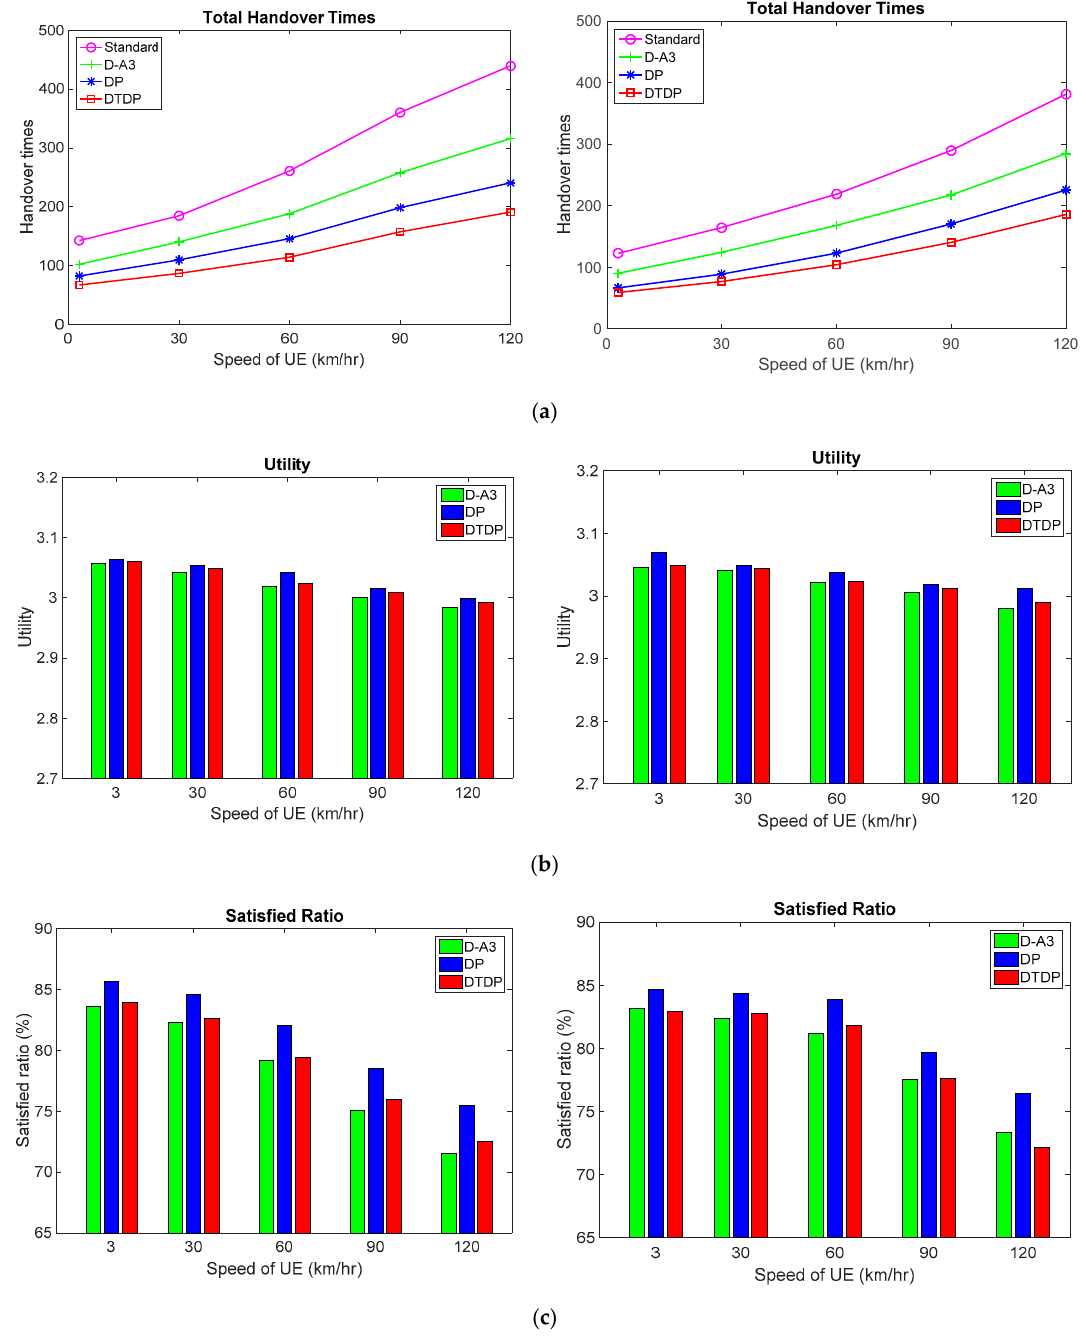
Figure 5. Total number of handovers, utility, and satisfied ratio versus the moving speed of each D2D user under different mobility models. The charts on the left and the charts on the right correspond to the FD model and RPGM model, respectively. ( a ) Total number of handovers; ( b ) utility; ( c ) satisfied ratio.